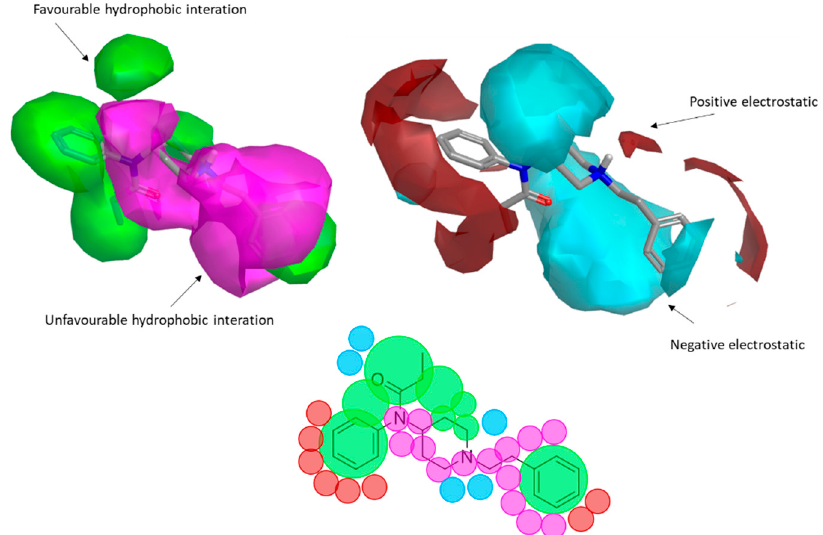
Figure 3. The AA model map is superimposed to fentanyl. Molecular insight of structure-activity relationship (SAR) mechanism models, revealing the different lead optimization sites of active compounds. Red color shows positive field region controlling the activity, and blue color the negative ones. Green color shows favorable shape/hydrophobic regions, and violet color the unfavorable ones.